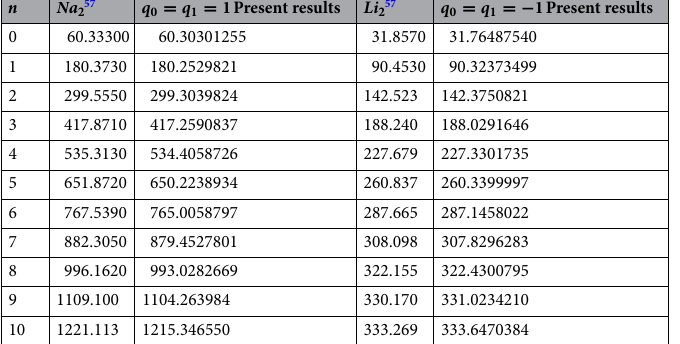
Table 2. Comparison of theoretical values with experimental (in cm −1 ) values for the vibrational energy levels of the modified deformed exponential-type molecular potential for 5 1 (cid:31) g state sodium dimer and a 3 (cid:31) + u state of lithium